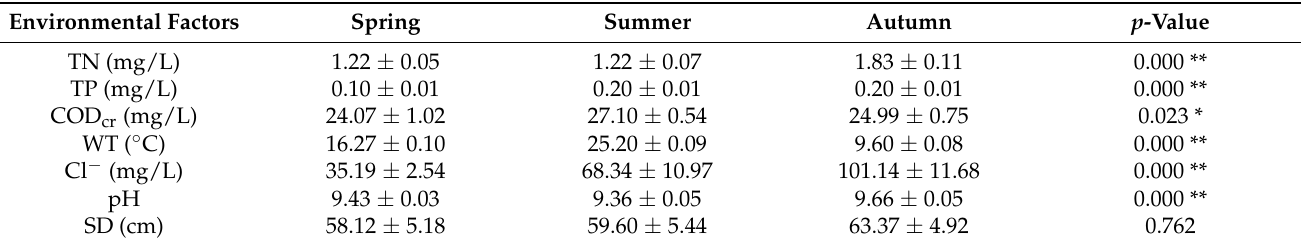
Table 2. Mean values of environmental factors in Zhalong wetland in three seasons ( ± standard